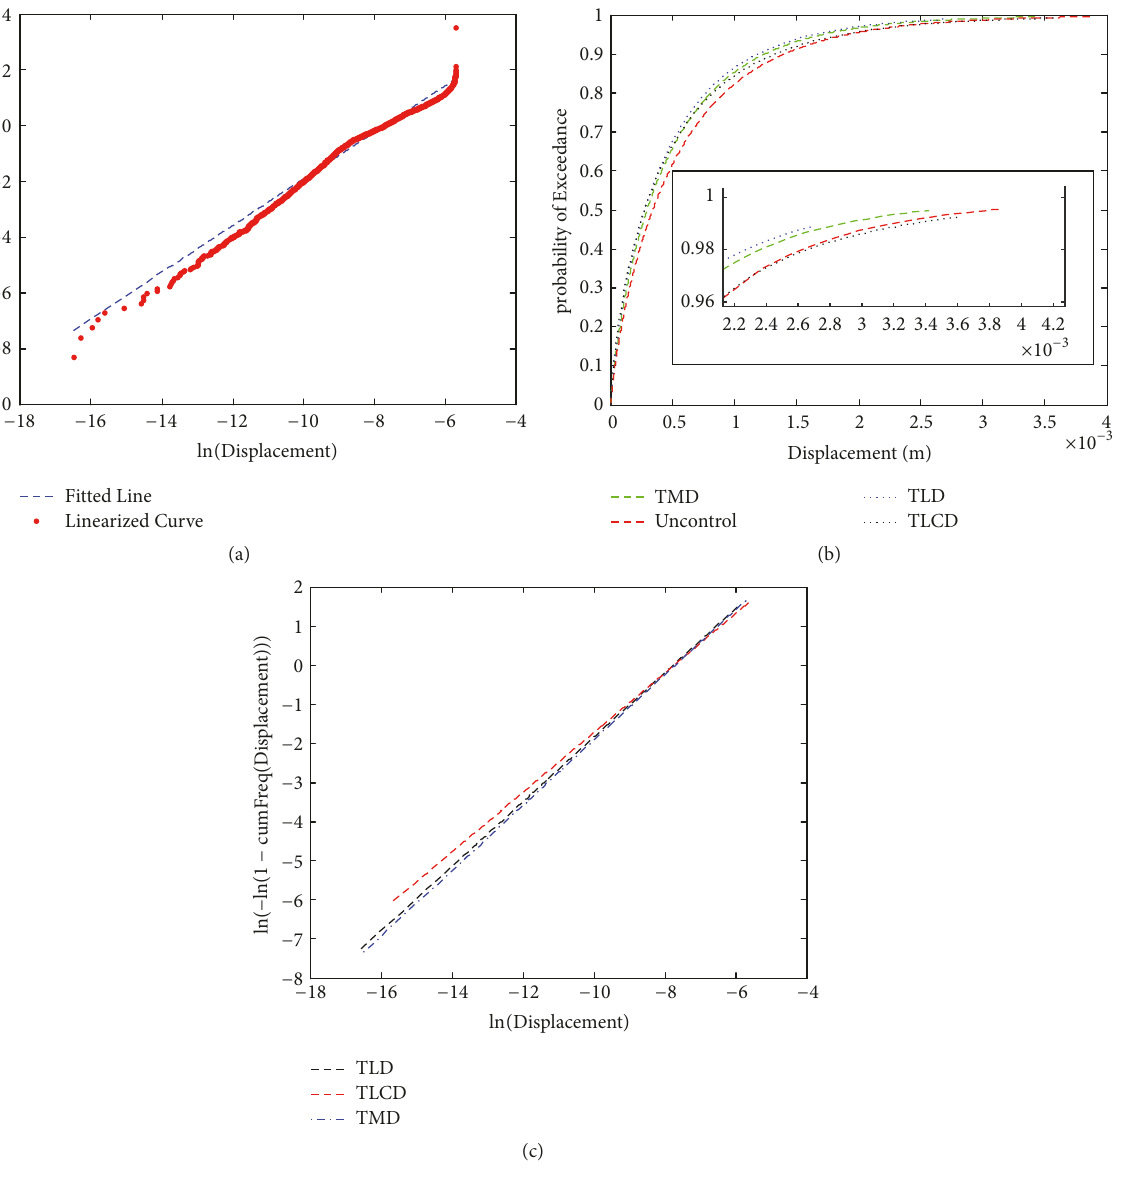
Figure 5: Weibull distribution for the controlling systems. (a) Linearized curve and fitted line comparison of TMD controller system. (b) Exceedance of the displacement probability. (c) Weibull